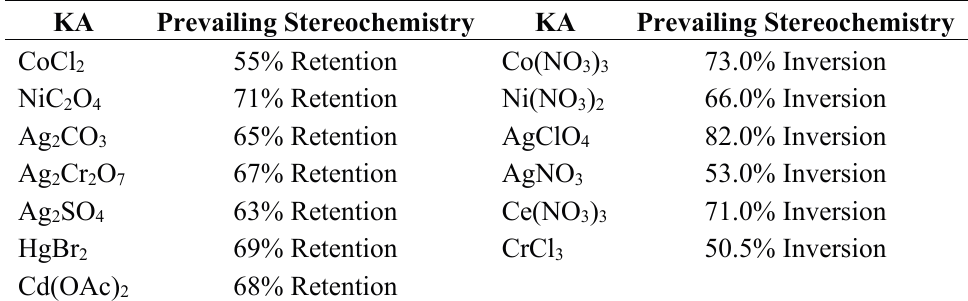
Table 6. The effect of inorganic salts (KA) on the steric course of the acid catalyzed isopropanolysis of sulfinamide (+)-( S )- 1c .